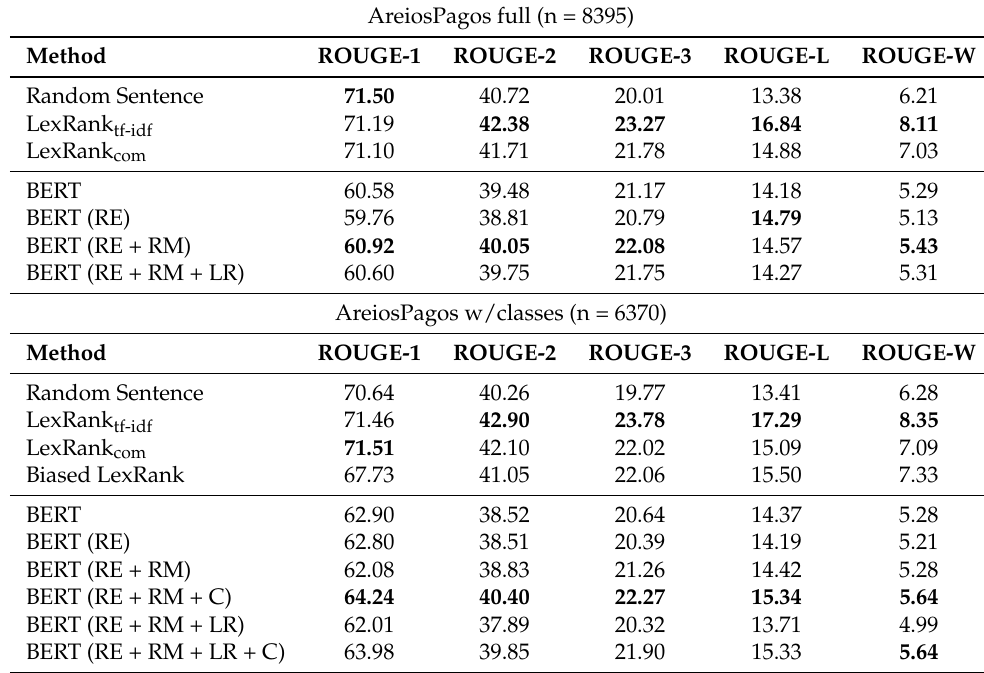
Table 4. Automatic evaluation results for the whole dataset and its subset containing classes, pre- sented in two segments of the table corresponding to (a) automatic extractive summarizers and (b) automatic abstractive summarizers. The extractive methods extract sentences until they reach three-times the length of the reference summary. In the abstractive models, we modified the inputs and labeled the models accordingly; RE : the text is rearranged so the case result is always included and at the start of the input, RM : less important parts of the text are removed, C : the case’s category tags are included at the start of the input, LR : the input document is halved using LexRank tf-idf . The ROUGE scores are F1-scores given in percentage (%) form. The ROUGE-L/W scores are reported without stopword removal for the BERT methods. The best-performing automatic method in each category is in bold